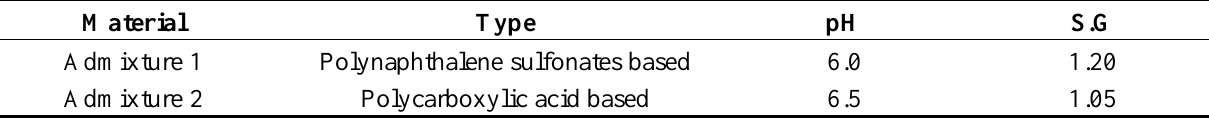
Table 4. Properties of the materials.